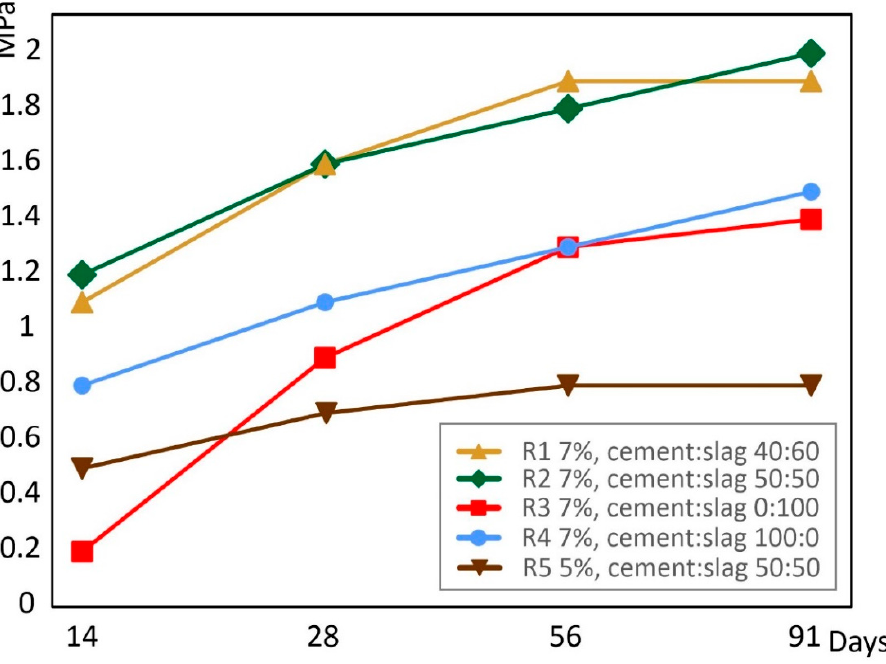
Figure 3. Compressive strength development of the CPB samples with different binder compositions (R1–R5, see Table 1.). A strength of 0.5 MPa should be achieved or exceeded within 14 days of curing for the specimens that have 7% of binder material (R1–R4) and in 28 days for a specimen containing 5% of binder material (R5). Only R3 did not have the desired strength at 14 days, but after 56 days of curing the R3 strength value was identical with that of R4.